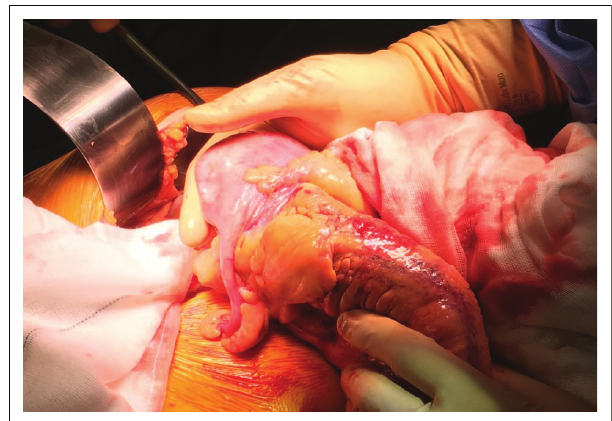
FIGURE 1: Ultrasound showing portal venous gas as diffuse echogenic foci and reflector shadows in the liver.